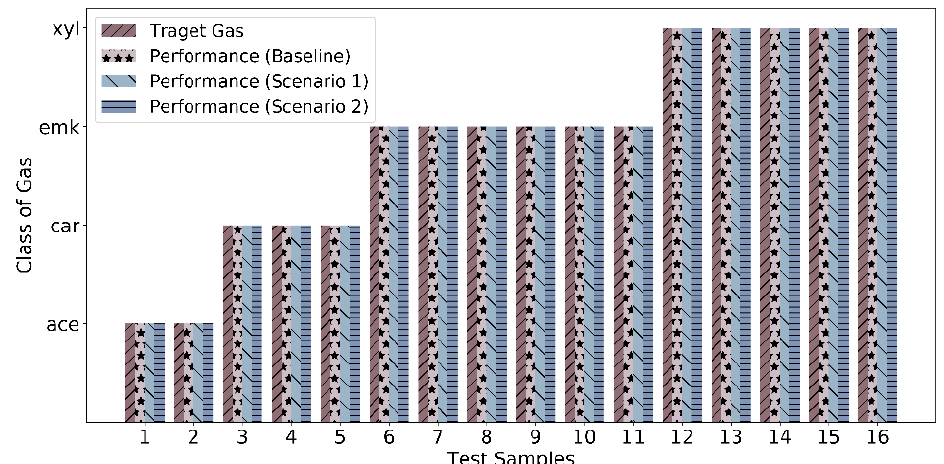
Figure 6. Classification performance in terms of actual vs. predicted target gas for baseline, scenario 1, and scenario 2 experiments.